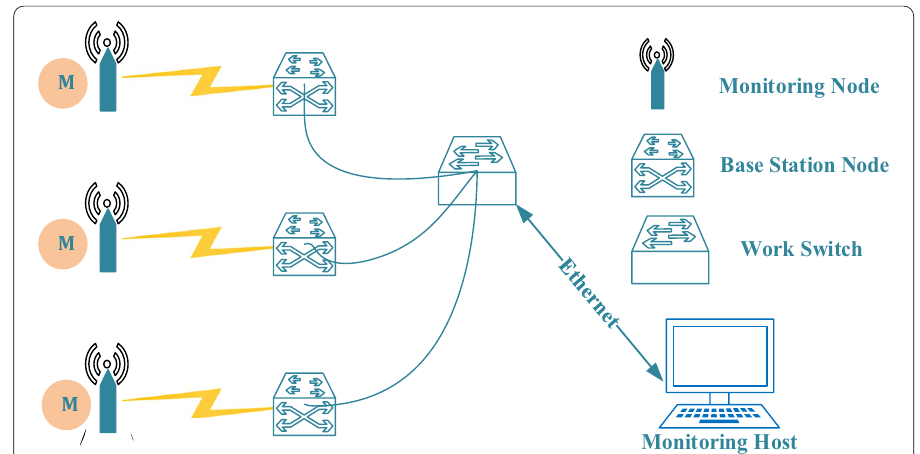
Fig. 2 Improved wireless sensor network monitoring hardware structure